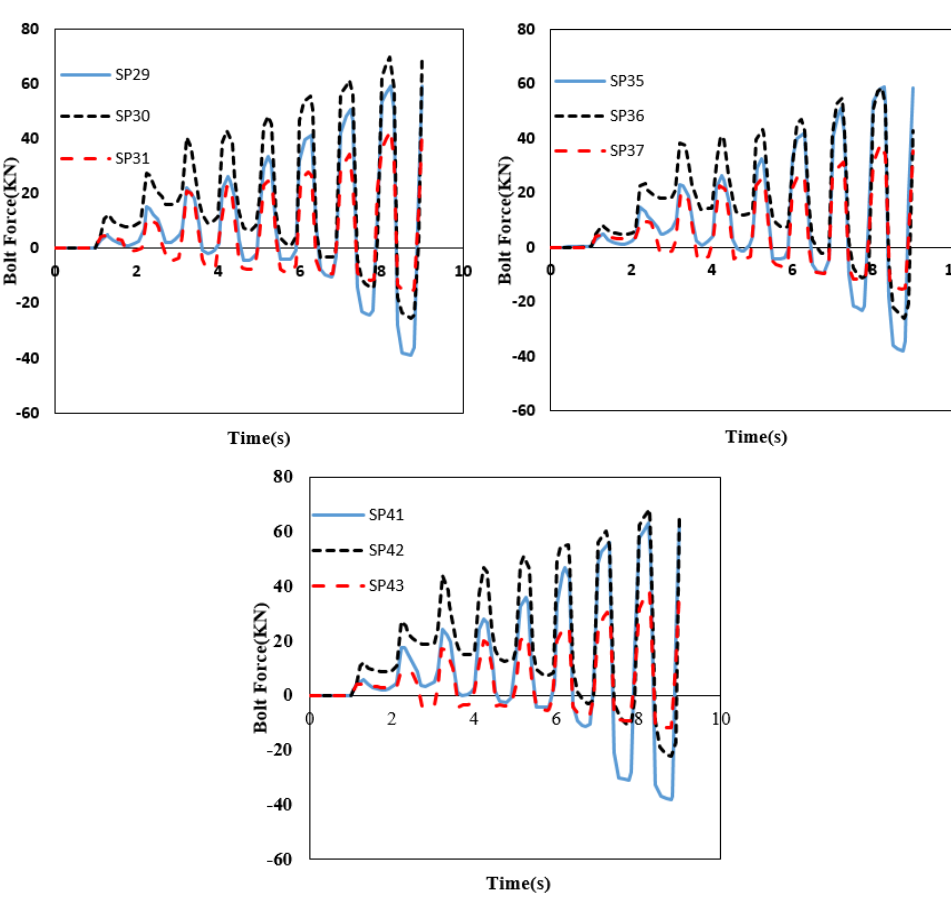
Figure 20. Bolt force and